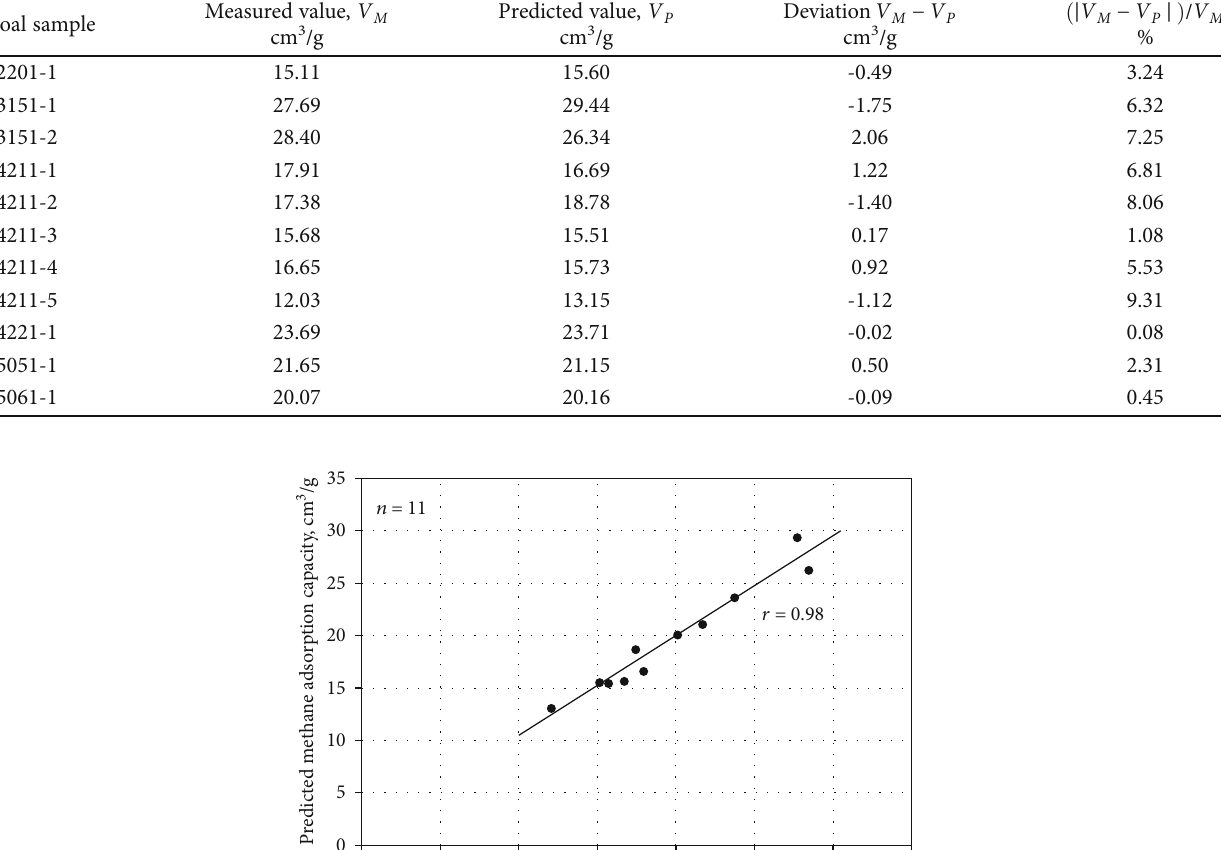
Table 2: Comparison of measured values and calculated values of methane adsorption capacity of the No. 2 Coal sample